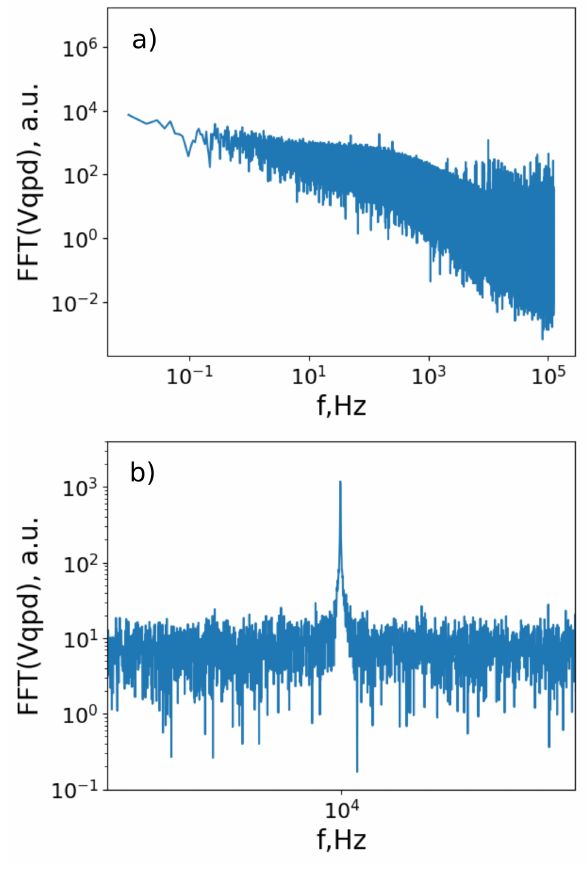
Figure 1. Fast Fourier Transform of the voltage readings of the quadrant photodiode (QPD) corresponding to the motion of the 490 nm TiO 2 nanoparticle inside of the optical tweezer a) full spectrum b) around the frequency of the applied field with char- acteristic broadening of the peak